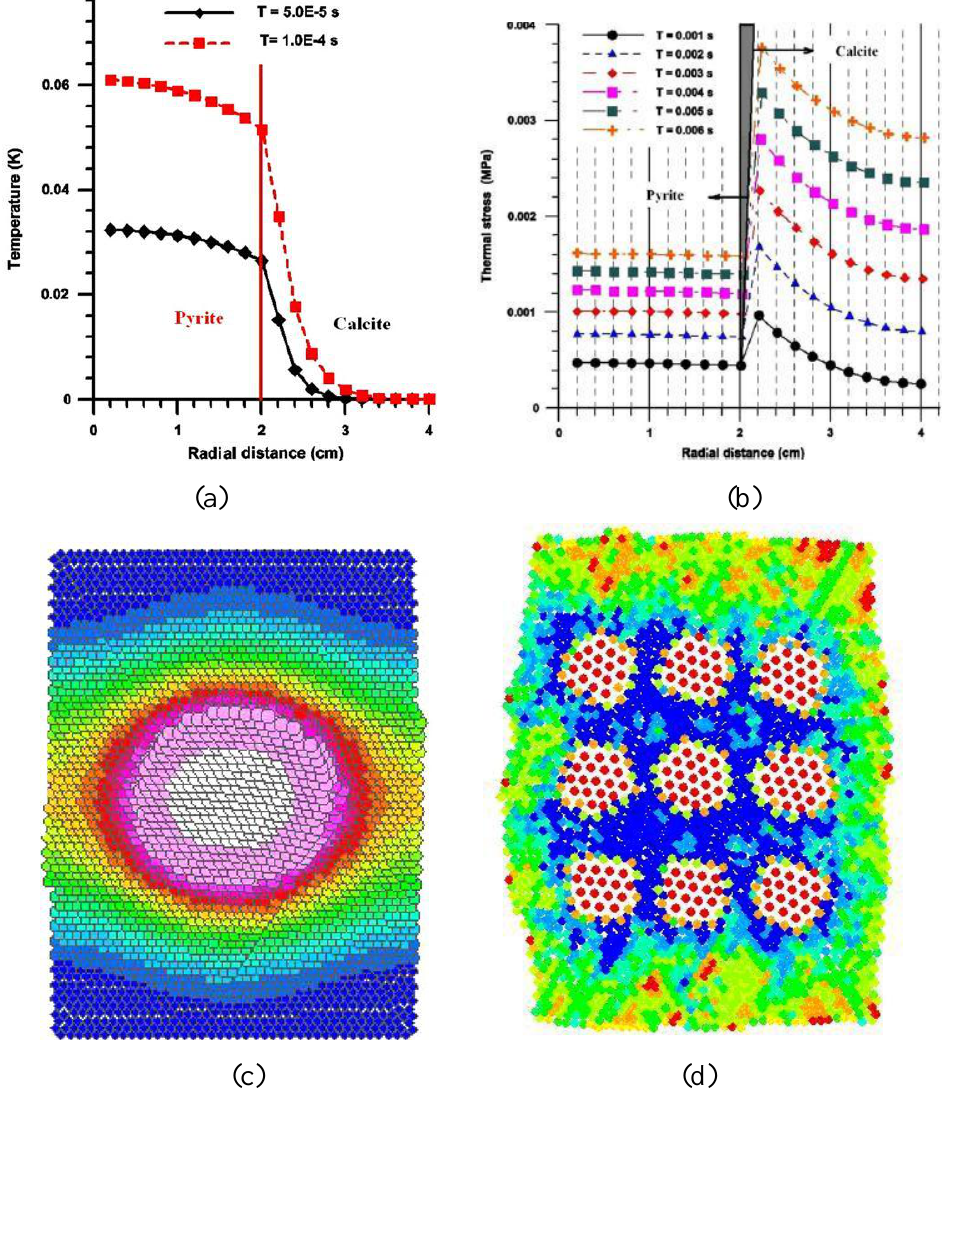
Figure 5. HLPM simulation of thermally-induced breakage of assemblage of pyrite-calcite, (a), (b) temperature, thermal stress versus radical displacement, (c) spatial temperature distribution within an one inclusion structure, (d) fracture distribution within